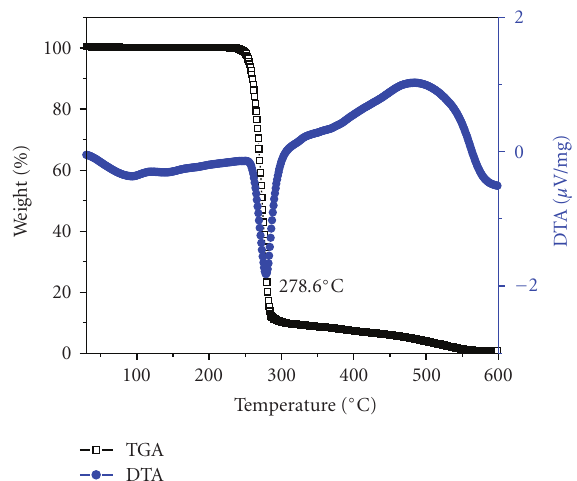
Figure 60: Simultaneous TGA-DTA of irradiated L-threonine single crystals at 1 × 10 11 ions/cm 2